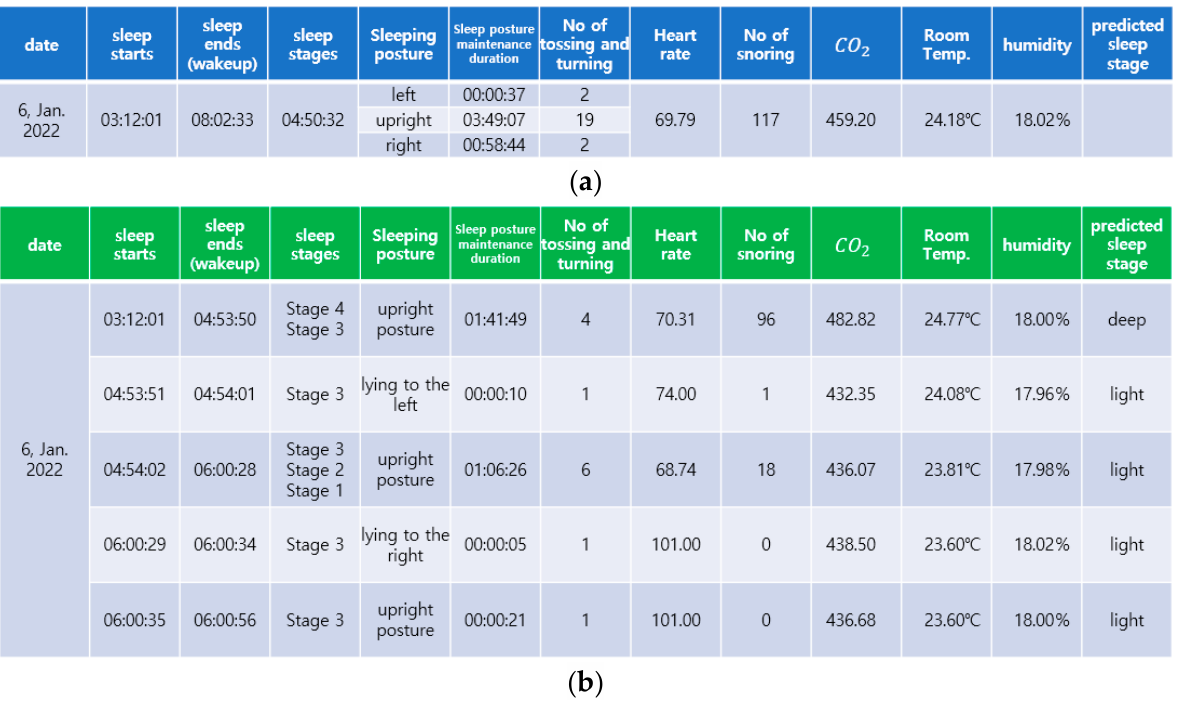
Figure 21. Summary of sleep information obtained during sleep. ( a ) Summary of the participant’s sleep information; ( b ) Summary of sleep information for the two sleep stages.